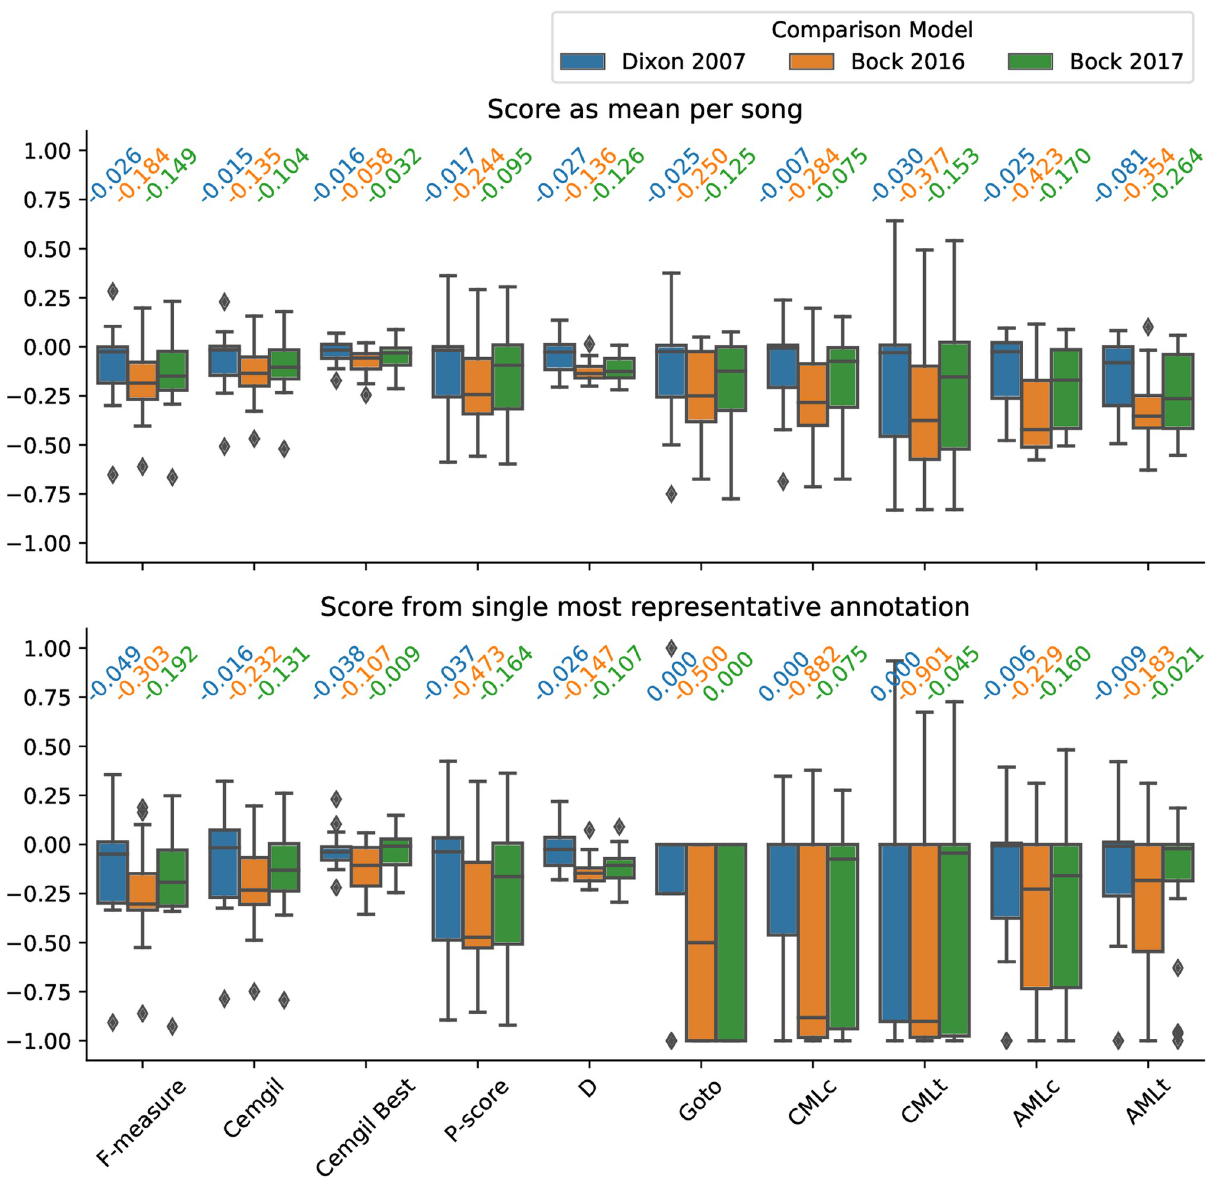
Fig 9. Comparison of THT beat tracking with Dixon 2007 [17], Bo¨ck 2016 [23] and Bo¨ck 2017 [25]. Score difference is presented as a distribution for each metric in the mir_eval package [38]. Each distribution is gathered from 20 points, one for each excerpt in the dataset. Score differences are calculated in two modalities, as the mean across annotators or by selecting a single most representative annotator per excerpt. Above each boxplot the median of each distribution is presented in